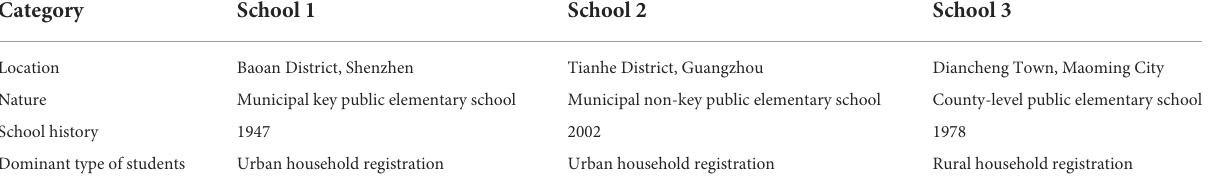
TABLE 1 Basic information of the three schools.